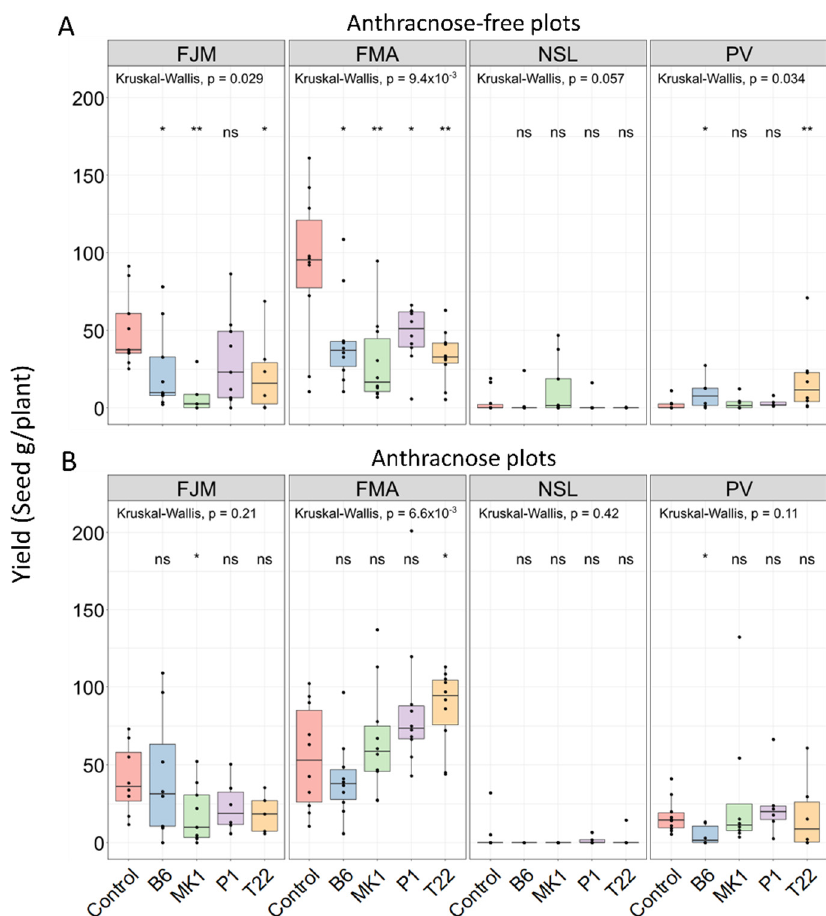
Figure 3. Effects of seed inoculation with Trichoderma and subsequent C. lindemuthianum inoculation on seed yield of common bean in the field. ( A ) Anthracnose-free plots: no C. lindemuthianum inoculation, ( B ) Anthracnose plots: plants inoculated with C. lindemuthianum . Bean cultivars, FJM: Flor de Junio Marcela; FMA: Flor de Mayo Anita; NSL: Negro San Luis; PV: Pinto Villa. Treatments, Control: No Trichoderma ; B6: T. asperellum B6; MK1: T. longibrachiatum MK1; P1: T. atroviride P1; T22: T. harzianum T22. Boxplots indicate medians, 25th and 75th percentiles, whiskers extend to 1.5 times the interquartile range, data points beyond whiskers represent outliers. Asterisks indicate significant effects of Trichoderma inoculation on seed yield of plants of the same cultivar and under the same anthracnose-condition (** p ≤ 0.01, * p ≤ 0.05, ns: p > 0.05; based on Wilcoxon post hoc tests of n = max. 10 independent biological replicates (or less in cases of high soilborne mortality).